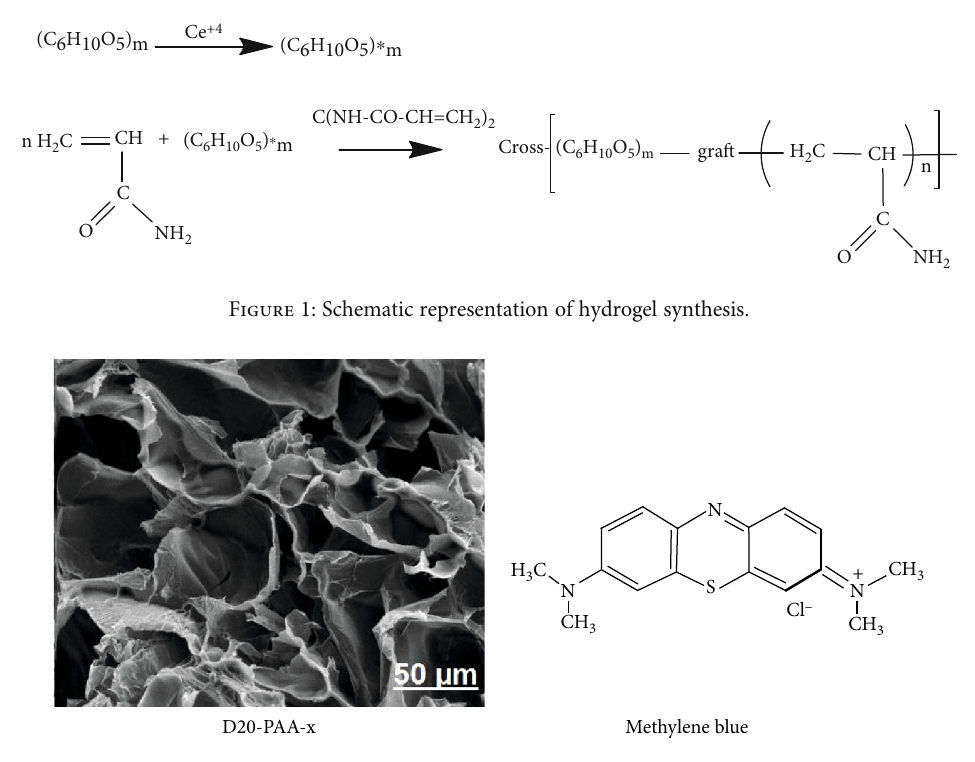
Figure 2: Internal structure of cross-linked copolymer networks and chemical structure of